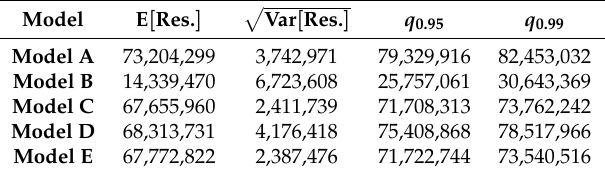
Table 6. Prediction results (RBNS) for individual approaches (XGBoost) using covariates.